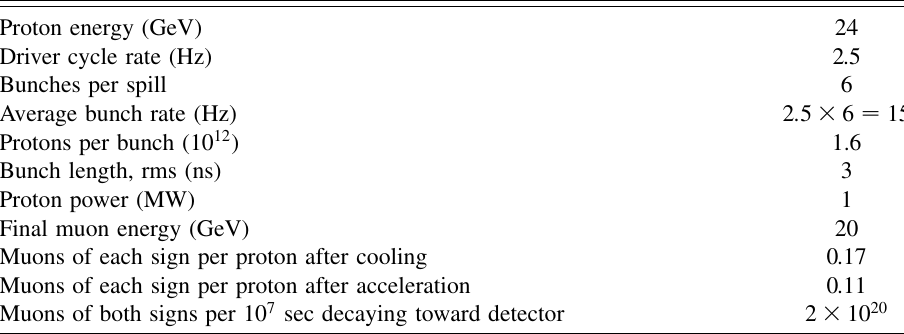
TABLE I. Summary of the main